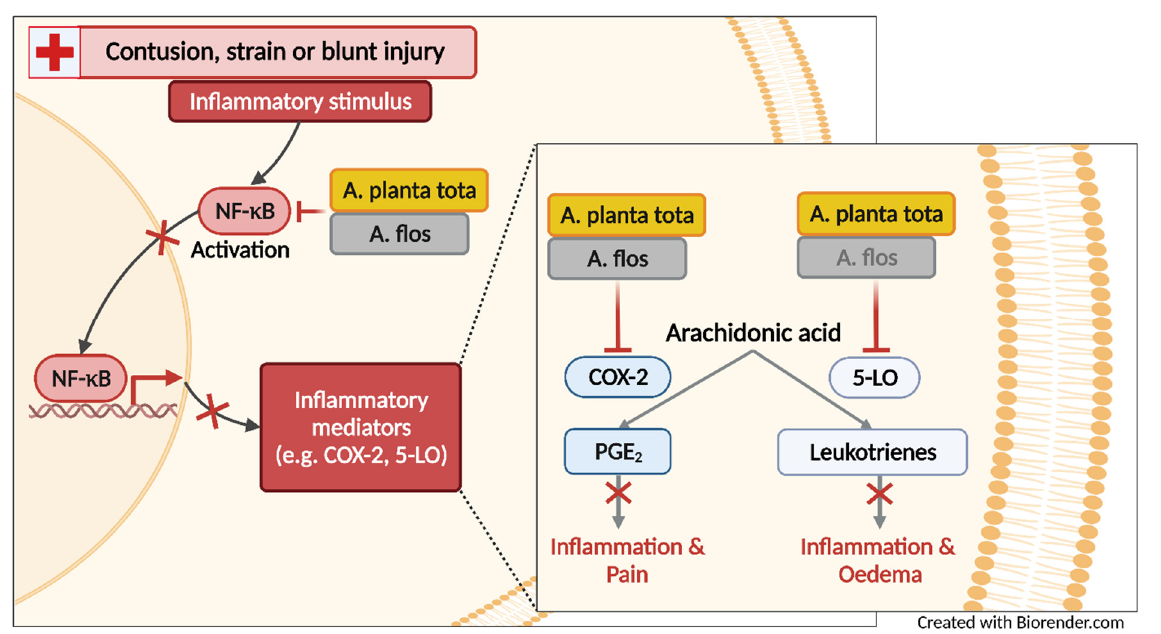
Figure 7. Inhibition of the NF-κB—eicosanoid inflammation pathway by Arnica montana extracts, as reported in this study. Arnicae planta tota and Arnicae flos both inhibited NF-κB activation, the expression and activity of 5-LO and COX-2 enzymes, and the release of eicosanoids (leukotrienes and prostaglandin PGE 2 ), to varying extents. Topical application of Arnicae planta tota and Arnicae flos also resulted in reduced paw oedema induced by carrageenan. Overall, the anti-inflammatory activity of Arnicae planta tota was either comparable to or stronger than that of Arnicae flos. Abbreviations: A. planta tota, Arnicae planta tota; A. flos, Arnicae flos; 5-LO, 5-lipoxygenase; COX-2, cyclooxygenase-2; NF- κ B, nuclear factor kappa B; PGE 2 , prostaglandin E 2 . Figure was created with BioRender.com (accessed on 13 December